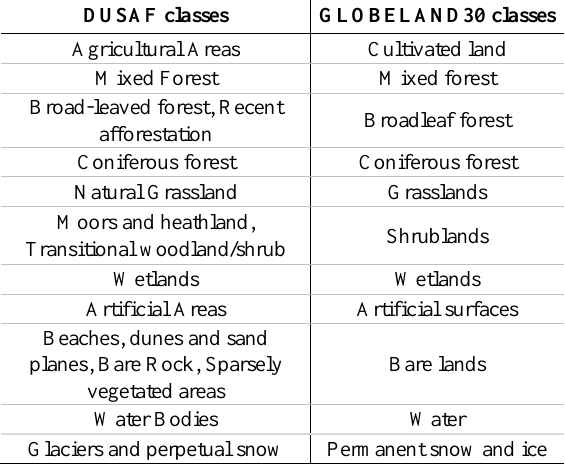
Table 1. Rules adopted to reclassify DUSAF according to